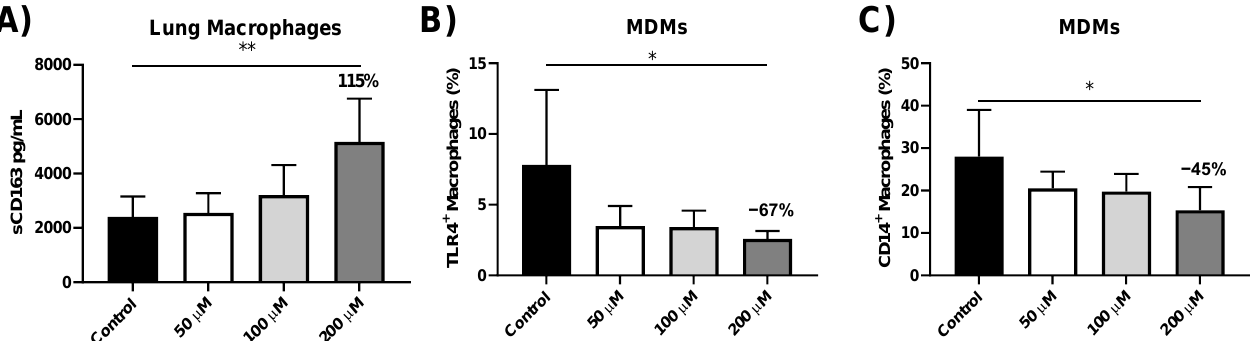
Figure 5. Protein levels in hemin-treated macrophages. ( A ) sCD163 levels in supernatants from lung macrophages treated with 50, 100 or 200 µ M of hemin. ELISA was used to assess levels of sCD163 after 24 h in smokers and COPD patients ( n = 8). Percentage of ( B ) TLR4 and ( C ) CD14-positive MDMs after 24 h treatment with 50, 100 or 200 µ M of hemin in COPD patients ( n = 5). One-way ANOVAs were carried out with a post hoc Dunnett’s multiple comparisons test against time-matched untreated controls. Data presented as ± SEM. Relative percentage changed indicated on graph. * = p < 0.05, ** = p < 0.01.